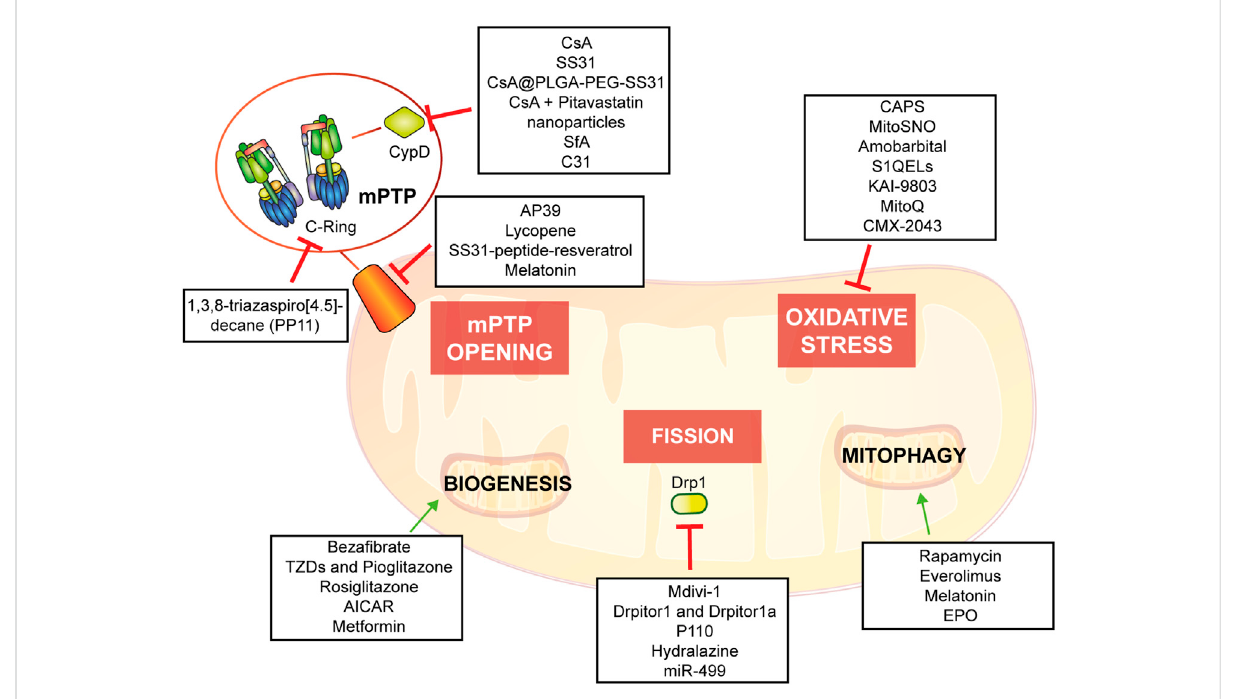
FIGURE 5 Potential mitochondria-targeting therapied as new approach to control heart tissue damage.